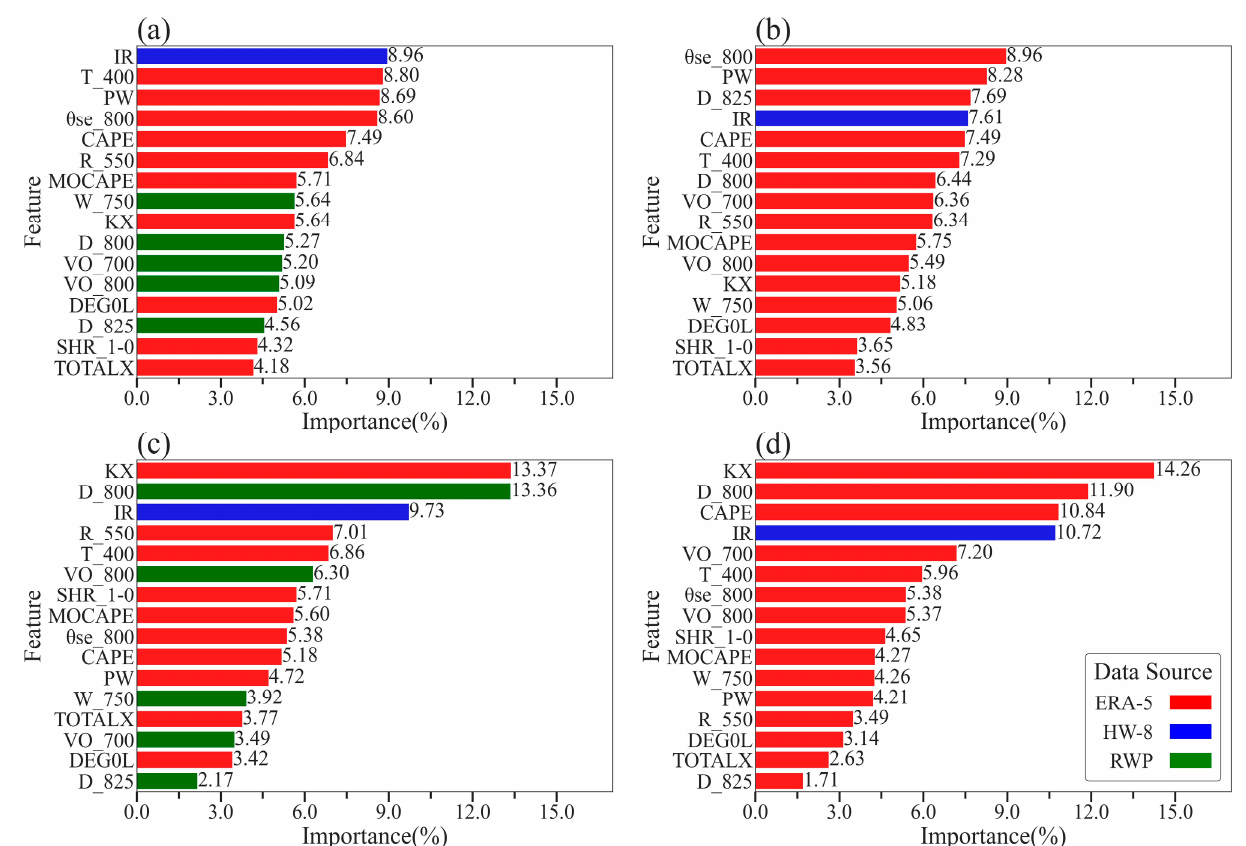
Figure 8. The feature importance score of the RF classification model for the rainfall/non-rainfall forecast ( a , b ) and rainfall grade forecast ( c , d ), which are based on the feature variables of D, ξ , and ω from different data sources (( a , c ) are from RWP and ( b , d ) are from ERA-5).